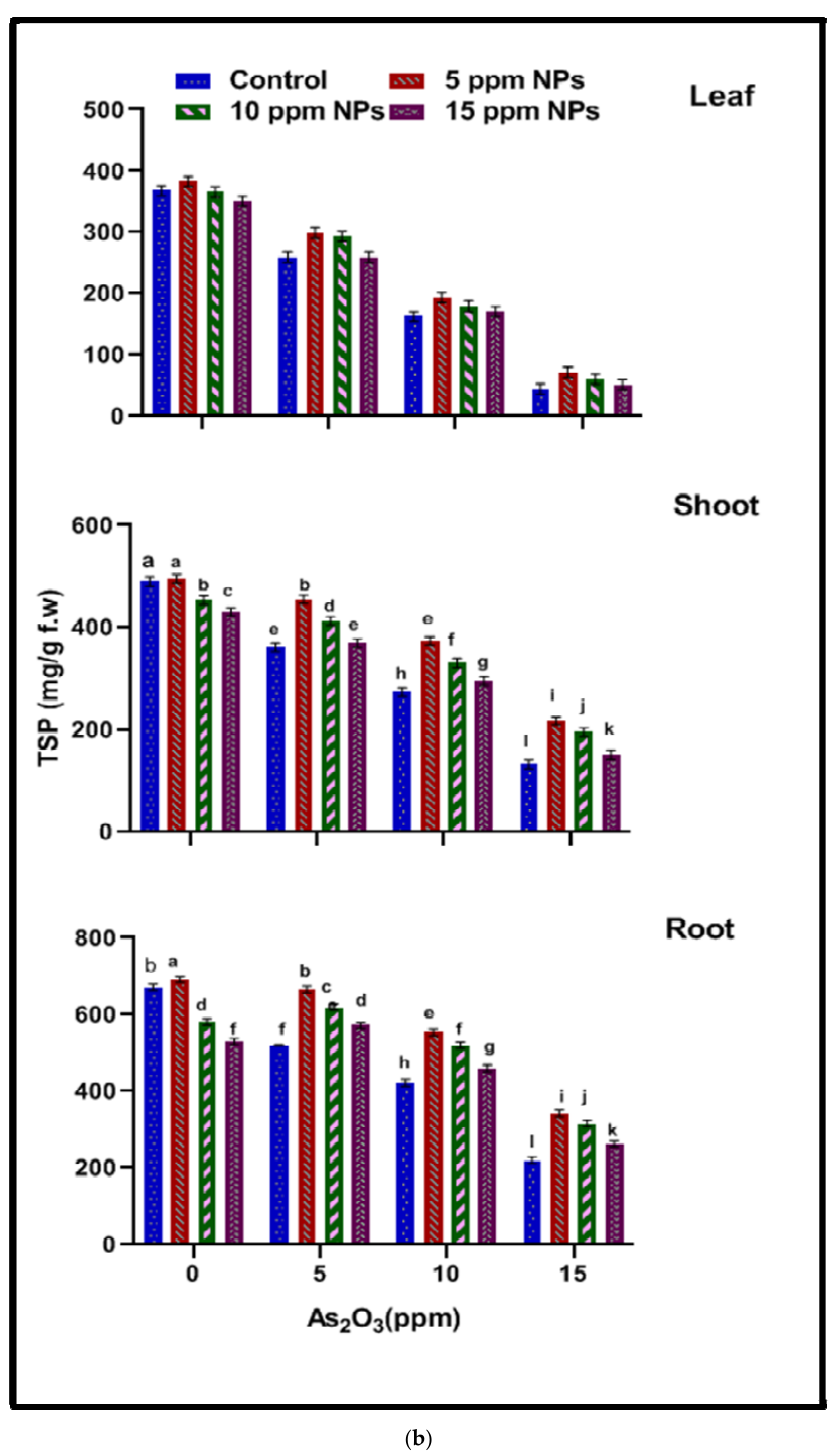
Figure 2. Effect of Bacillus subtilis -synthesized iron oxide nanoparticles on TSS ( a ) and TSP ( b ) content of rice ( Oryza sativa L.) in arsenic contaminated water. Different letters indicate significant differences ( p < 0.05) between treatments.